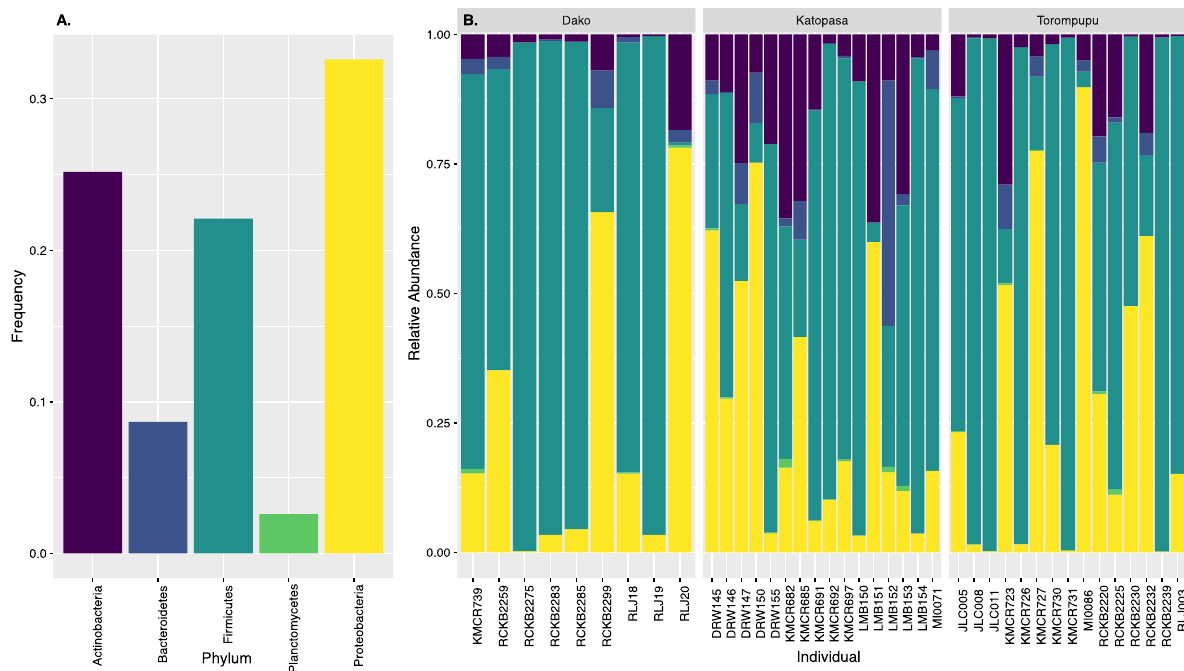
Fig. 2 Absolute frequencies in all samples ( A ) and the relative abundances of each individual ( B ) of the 5 most abundant phyla of ASVs from the